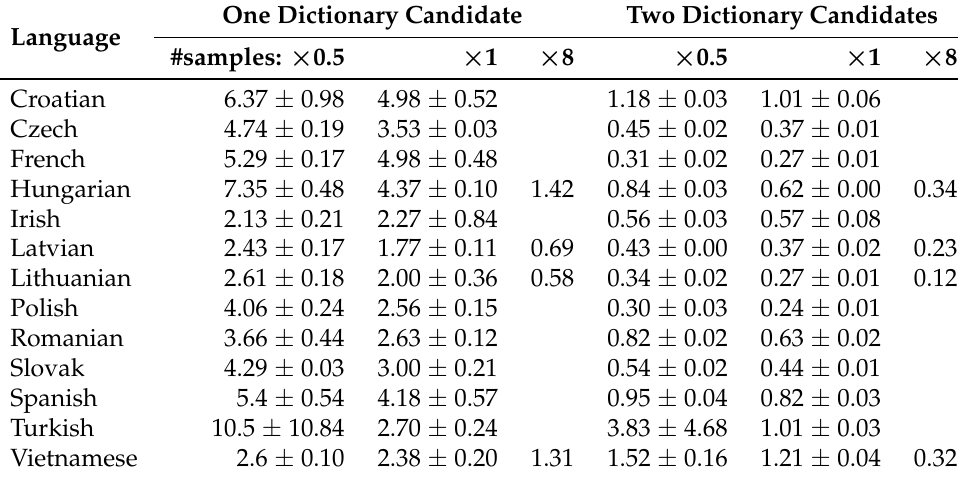
Table 4. Alpha-word error ratio between the ByT5 and Dictionary methods for two word groups and models in different training stages. The values higher than 1 indicate that the Dictionary method restores diacritics better. The first word group corresponds to words with exactly one possible translation target, and the second word group corresponds to words with two translation targets. Groups are determined by the training set statistics, while results are reported on the testing